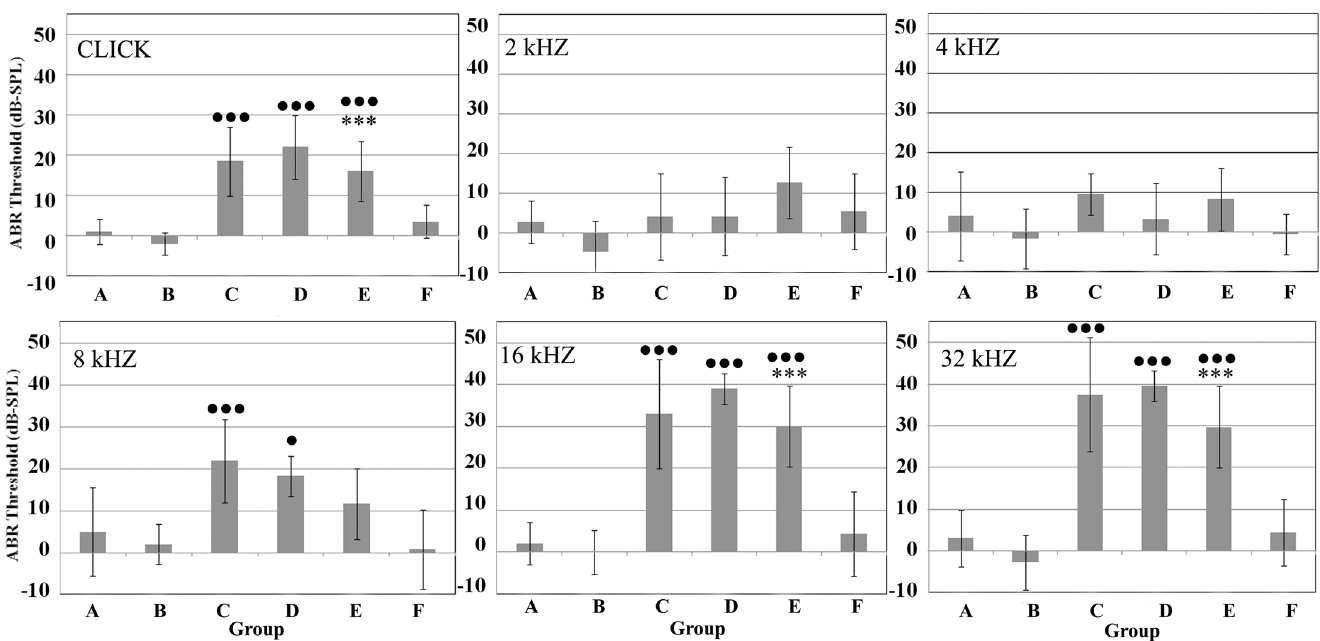
Fig 2. ABR threshold shifts for each treatment group (A-F) at different frequencies. ABR thresholds are expressed in dB ± standard deviation. ANOVA p-value significance in all groups of treated animals versus untreated controls (A): ● < 0.05; ●● < 0.01; ●●● < 0.001; ANOVA p-value significance between groups untreated and treated with Acu-Qter (A and B, C and D, E and F): *** < 0.001.